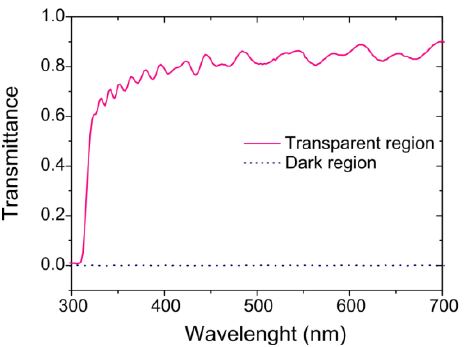
Figure 3. Transmittance of photomask in the transparent and dark